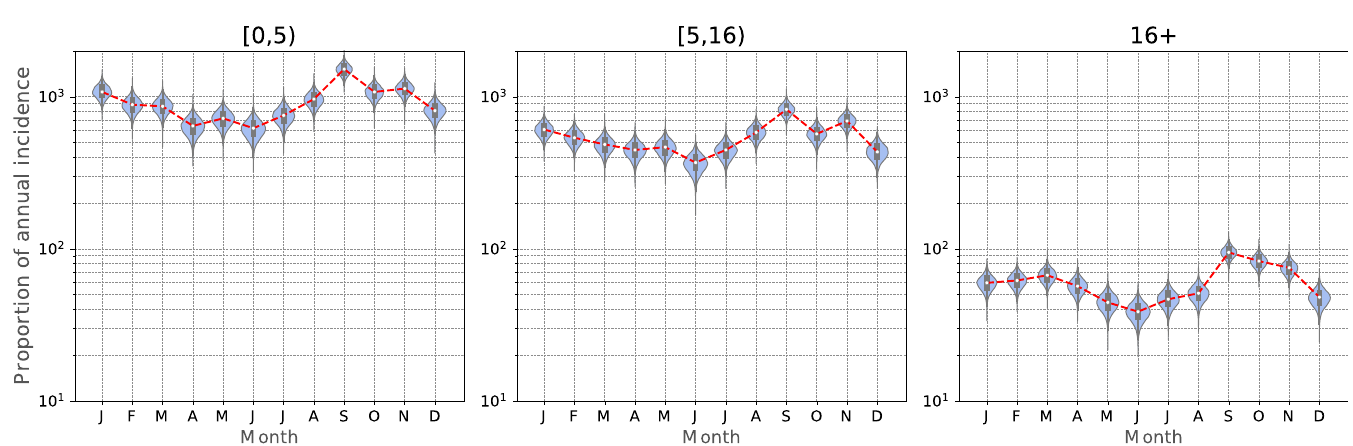
Fig 6. Age-specific seasonality in incidence (1982–1990). The figure demonstrates the year-to-year variation in the reported cases during each month for each age group. The distributions are generated from 10000 bootstrap samples of size 1000. The proportions for each age group is scaled by total cases in the corresponding age group. The relative incidence in each age group (scaled by the number of cases in the adult age group) is: 15.2, (11083 total cases), 8.88 (6474 total cases), and 1 (729 total cases), respectively. The amplitude of seasonality for each age group (calculated as (max-min)/average) is: 0.974, 0.847 and 0.926, respectively. Similarly, the standard deviation in intra-annual incidence for each age group is: 0.0228, 0.0196 and